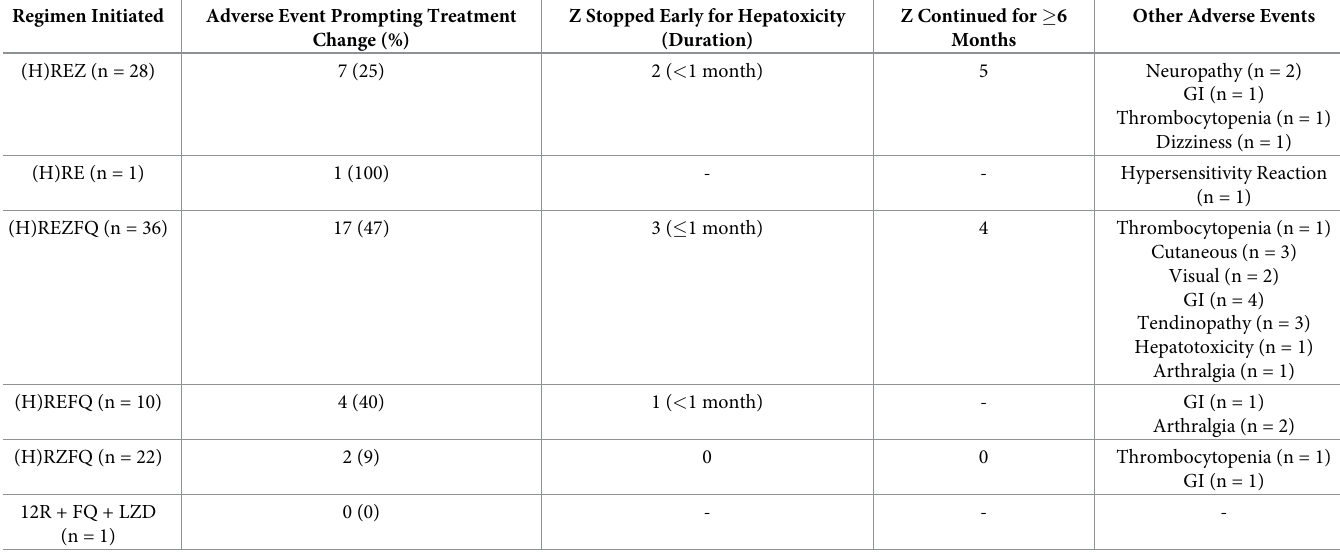
Table 2. Adverse effects prompting treatment change, categorized by